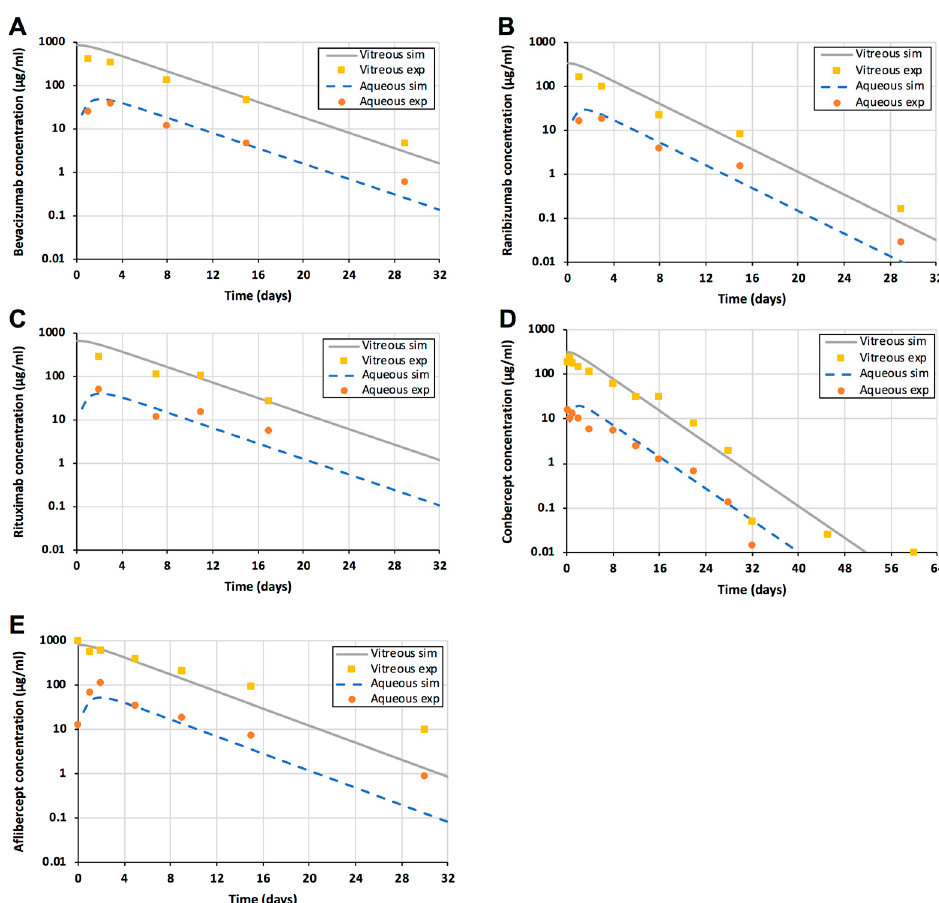
Figure 2. Experimental data and simulations of intravitreal injections of bevacizumab ( A ), ranibizumab ( B ), rituximab ( C ), conbercept ( D ), and aflibercept ( E ). Experimental (symbols) and simulated (lines) protein drug concentrations in the vitreous (yellow squares) and aqueous humor (orange spheres) are shown. The simulated vitreal and aqueous humor concentrations are shown as a grey solid line and a blue dashed line, respectively.